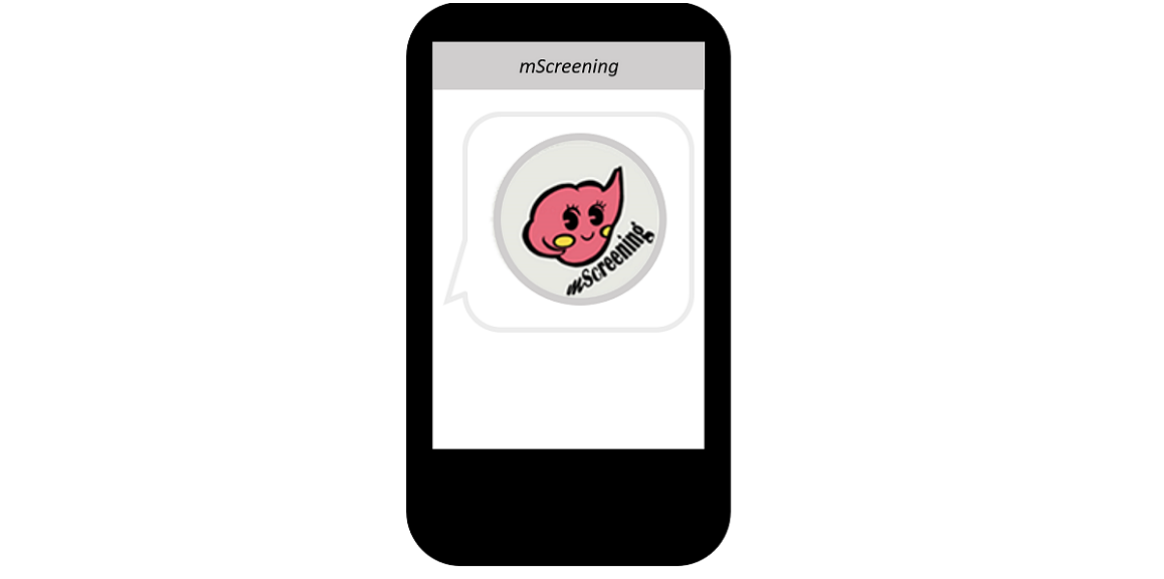
Figure 7. Mobile screening message example: created a study project